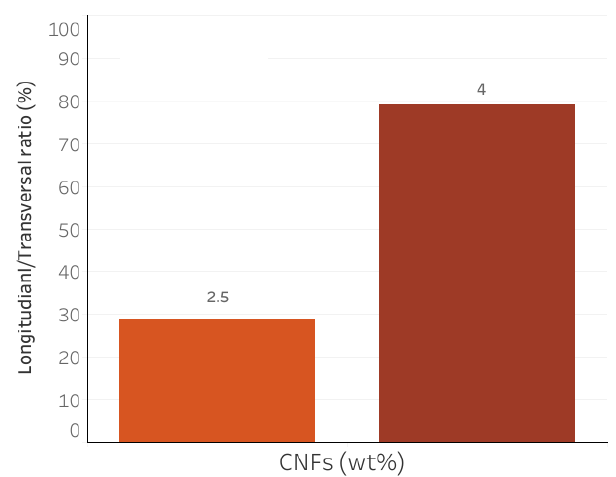
Figure 2. Electrical conductivity ratio of the electrical conductivity measured along the longitudi- nal/transversal direction of